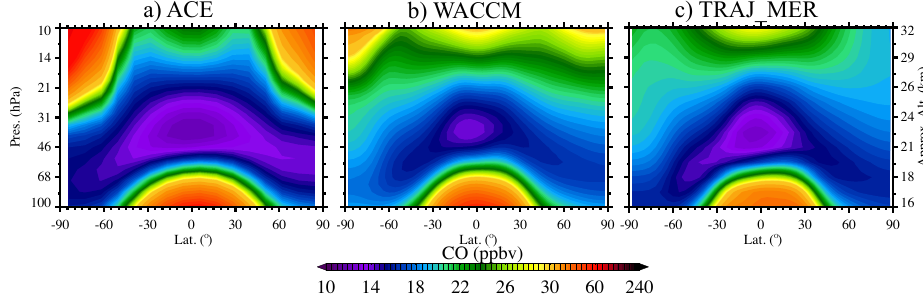
Figure 8. Zonal mean cross sections of CO from (a) ACE-FTS, (b) WACCM, and (c) trajectory model driven by MERRA